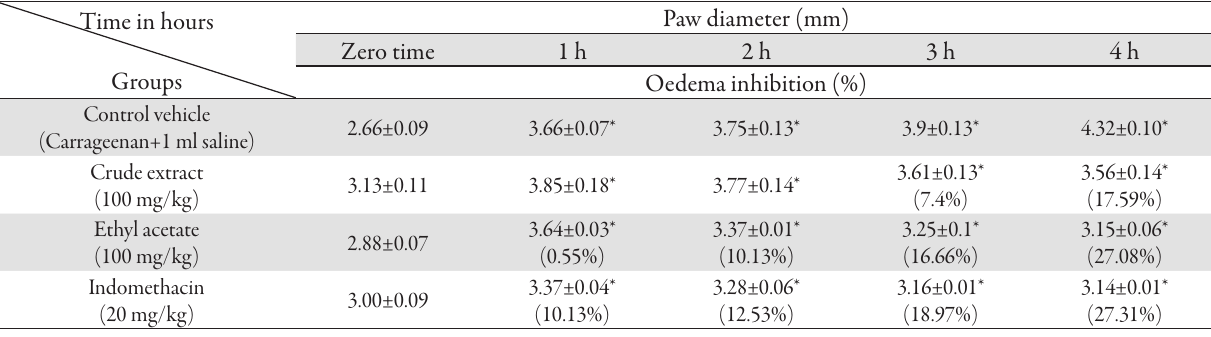
Tab. 1. Acute inflammatory activity of S. persica extracts and indomethacin (reference drug) on Carrageenan induced paw oedema in rats